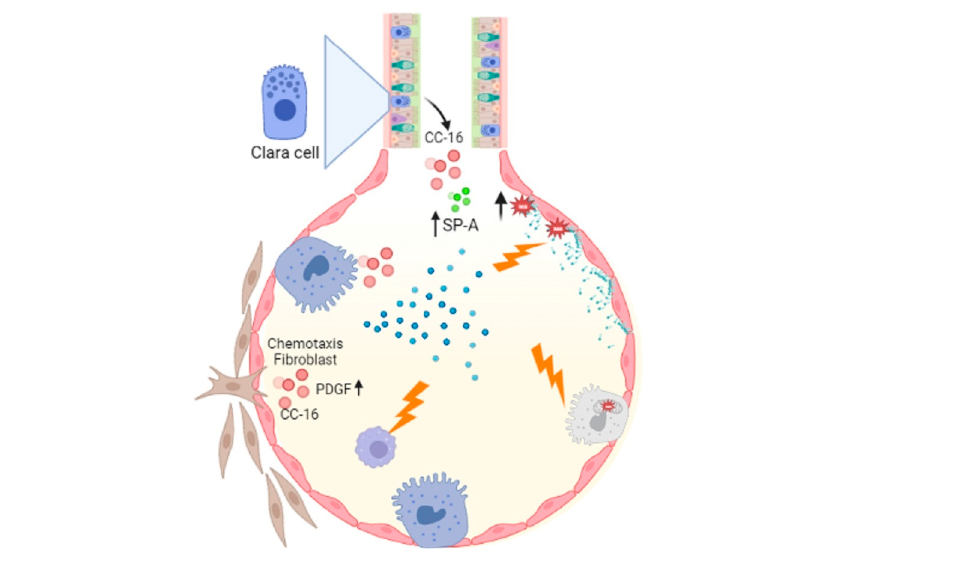
Figure 1. Asbestosis influences macrophage activity which is important for eliminating cellular de- bris, and acts on ATII cells by activating the mitochondrial and p53 death pathways. Asbestos cata- lyzes lipid peroxidation by decreasing PLC, which decreases phosphatidylinositol, phosphatidyl- glycerol, and phosphatidylserine synthesis. Another important event is the alteration of CC-16 with fibroblast chemotaxis activity, increased Sp-A and PLA2. Figure created in BioRender.com.